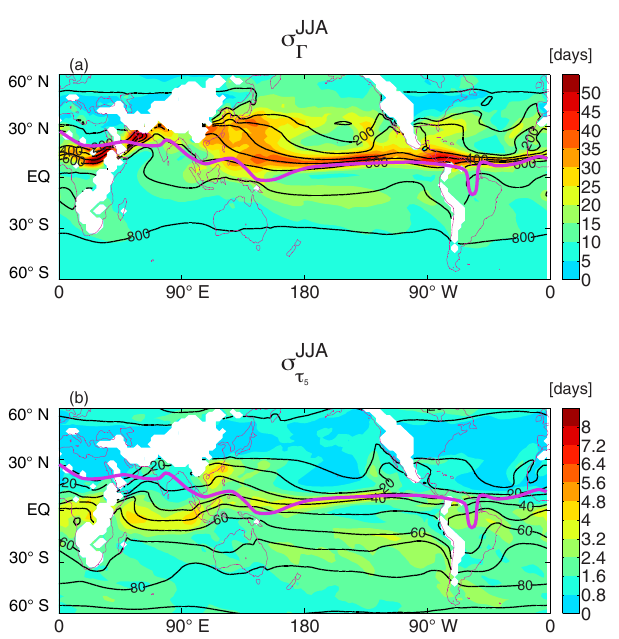
Figure 11. Same as Fig. 8 but for JJA interannual standard devia- tion.